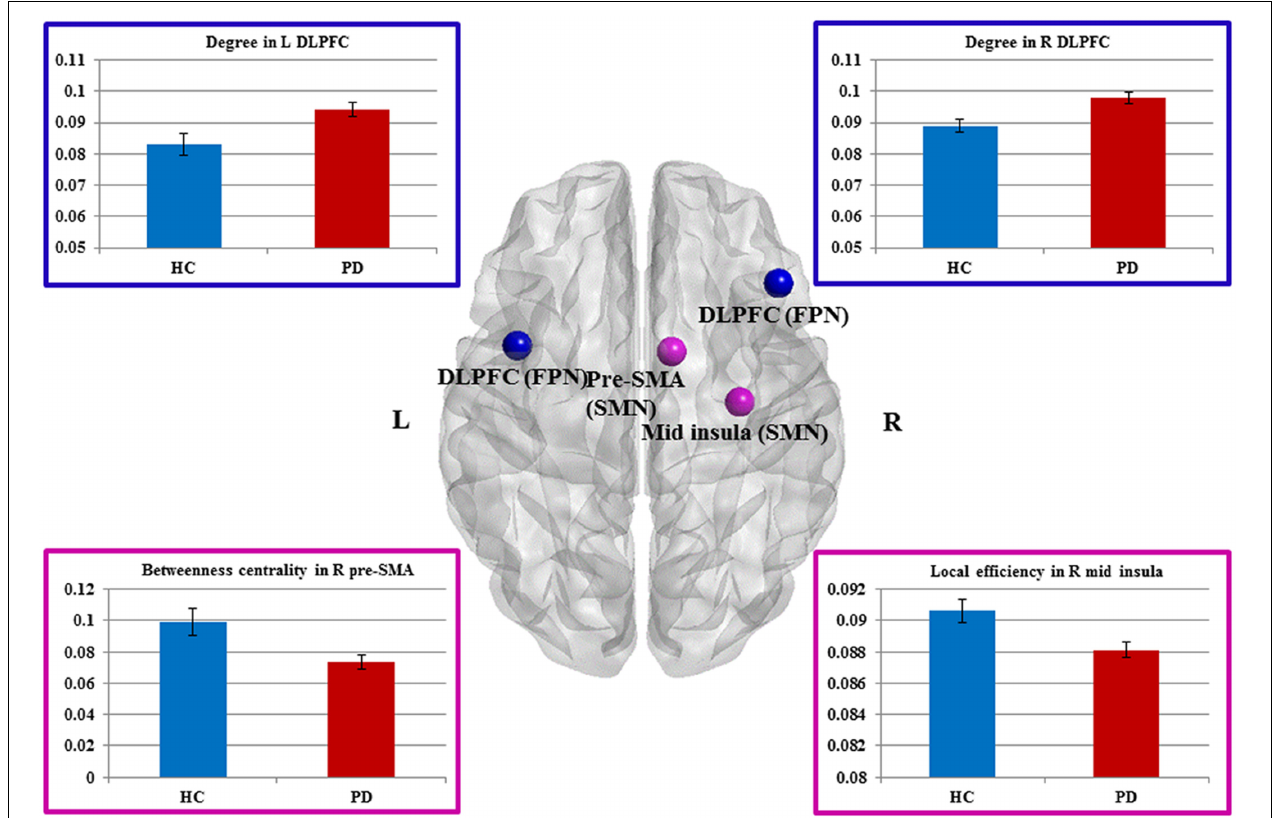
FIGURE 2 | Sensorimotor and fronto-parietal nodes showing group differences. Dorsal view of brain image presenting four nodes showing group differences. Increased degree in the bilateral DLPFC of FPN, as well as decreased betweeness centrality in the right pre-SMA and decreased local efficiency in the right mid-insula of SMN in Parkinson’s disease (PD) patients compared with healthy controls (HCs) ( P ≤ 0.005, uncorrected). The nodes are presented in equal size for visualization purposes. Brain image and nodes are visualized using the BrainNet Viewer (NKLCNL, Beijing Normal University). Bar graphs show the averaged values of each graph measure for HCs and PD (patients with Parkinson’s disease). Error bars represent standard error of the